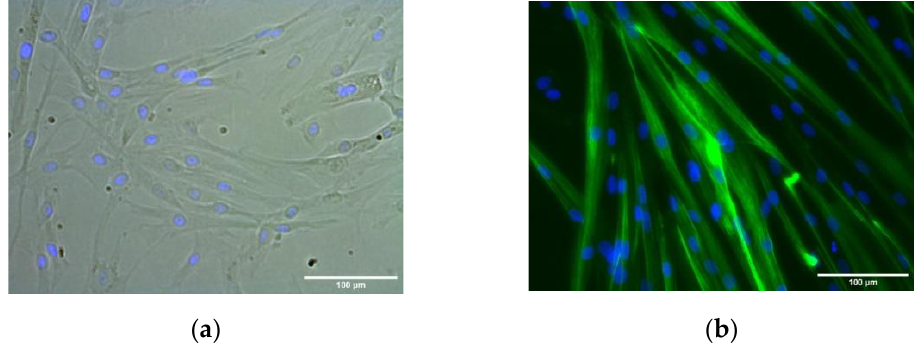
Figure 3. HSMM differentiation into multinucleated myotubes. Representative phase contrast ( a ) and dark-field images ( b ) of MYH2-immunostained cells (green), with Hoechst-labeled nuclei (blue) after 1 day growth medium (phase contrast image, ( a )) and 3 days in the differentiation medium (dark-field image, ( b )). (Images at ×20 magnification; scale bar = 100 microns).